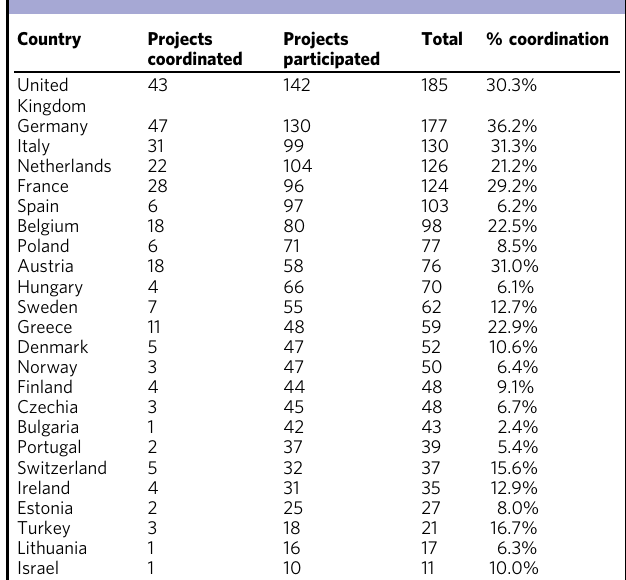
Table 4 Participation of countries in projects in the Social Sciences and Humanities funded under